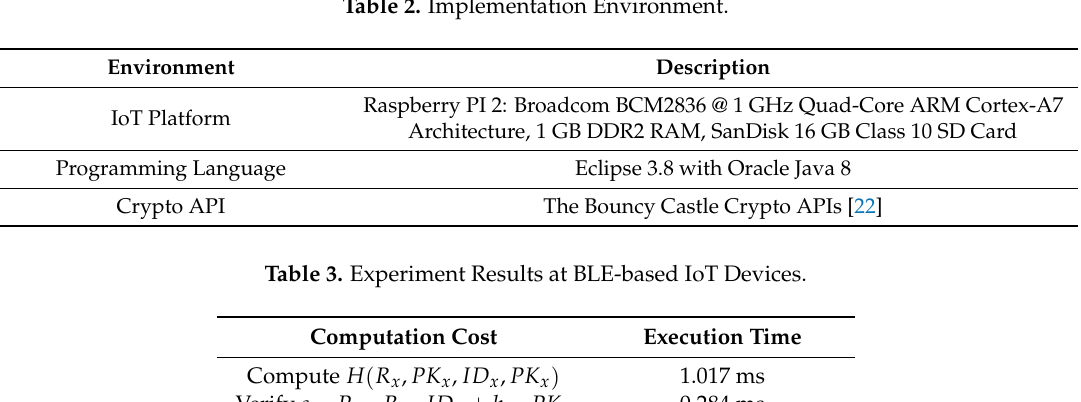
Table 2. Implementation Environment.